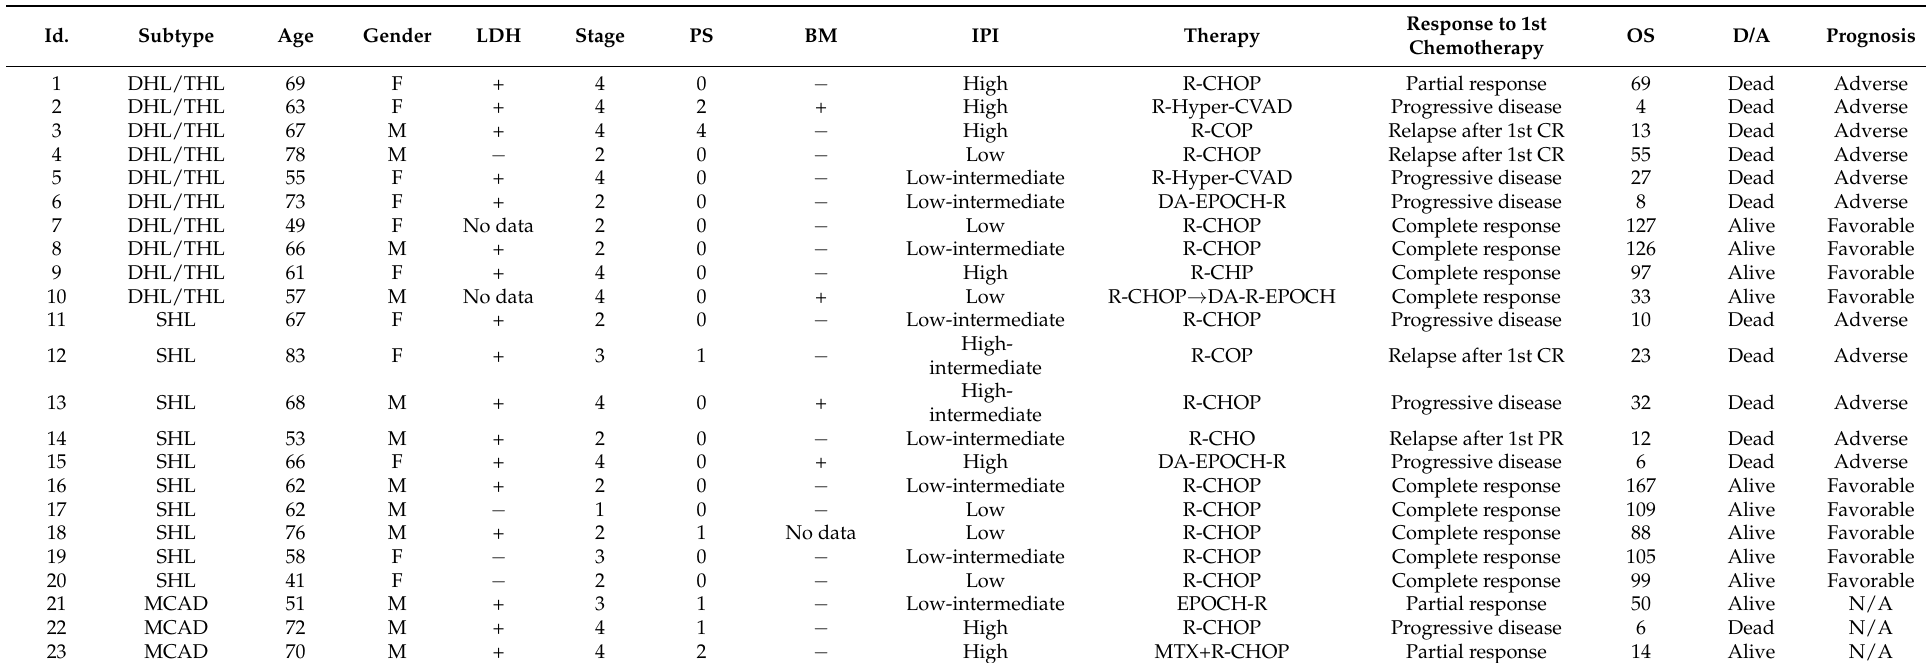
Table A1. Clinicopathological data of the 23